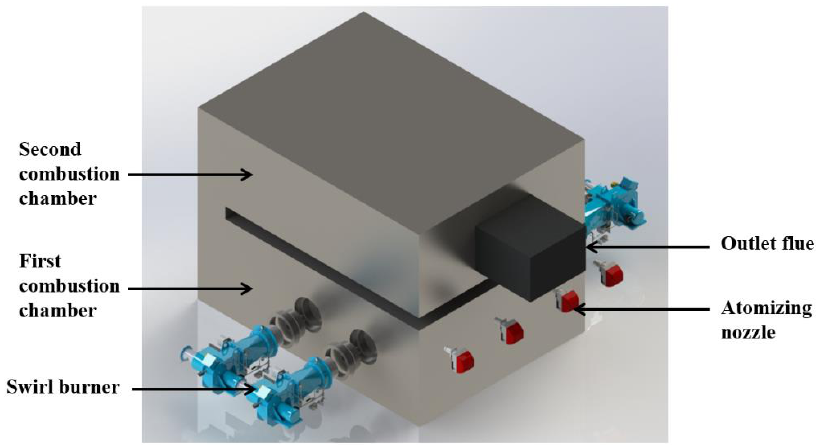
Figure 1. Three-dimensional model of the incinerator for the landfill leachate concentrate.